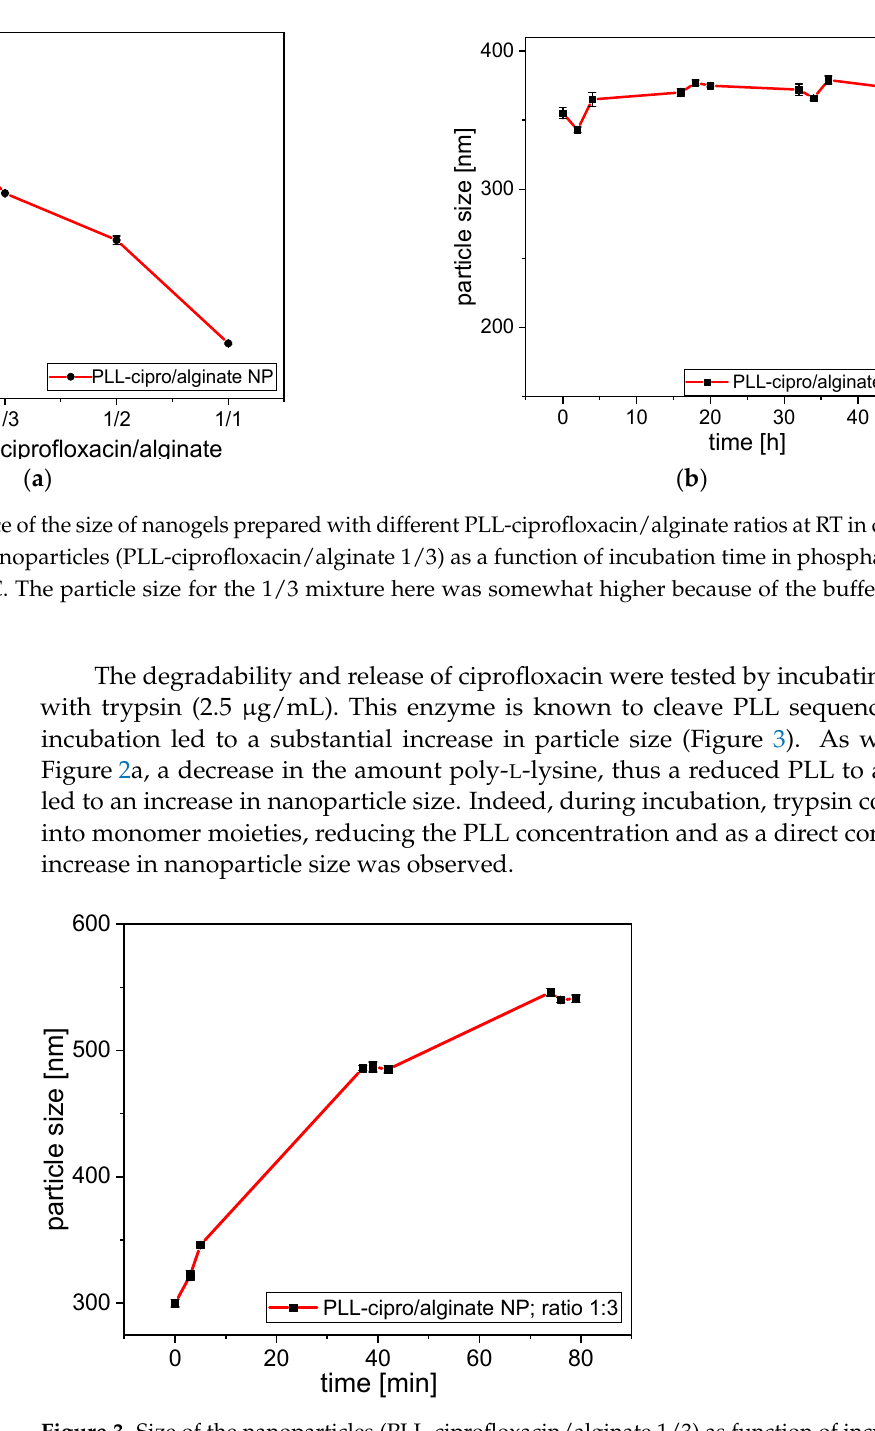
Figure 3. Size of the nanoparticles (PLL-ciprofloxacin/alginate 1/3) as function of incubation time in phosphate buffer saline (pH 7.4) at 37 °C after addition of trypsin (final concentrations of 2.5 µg/mL).